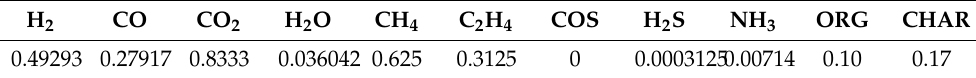
Table 3. Stoichiometric coefficients for Reaction